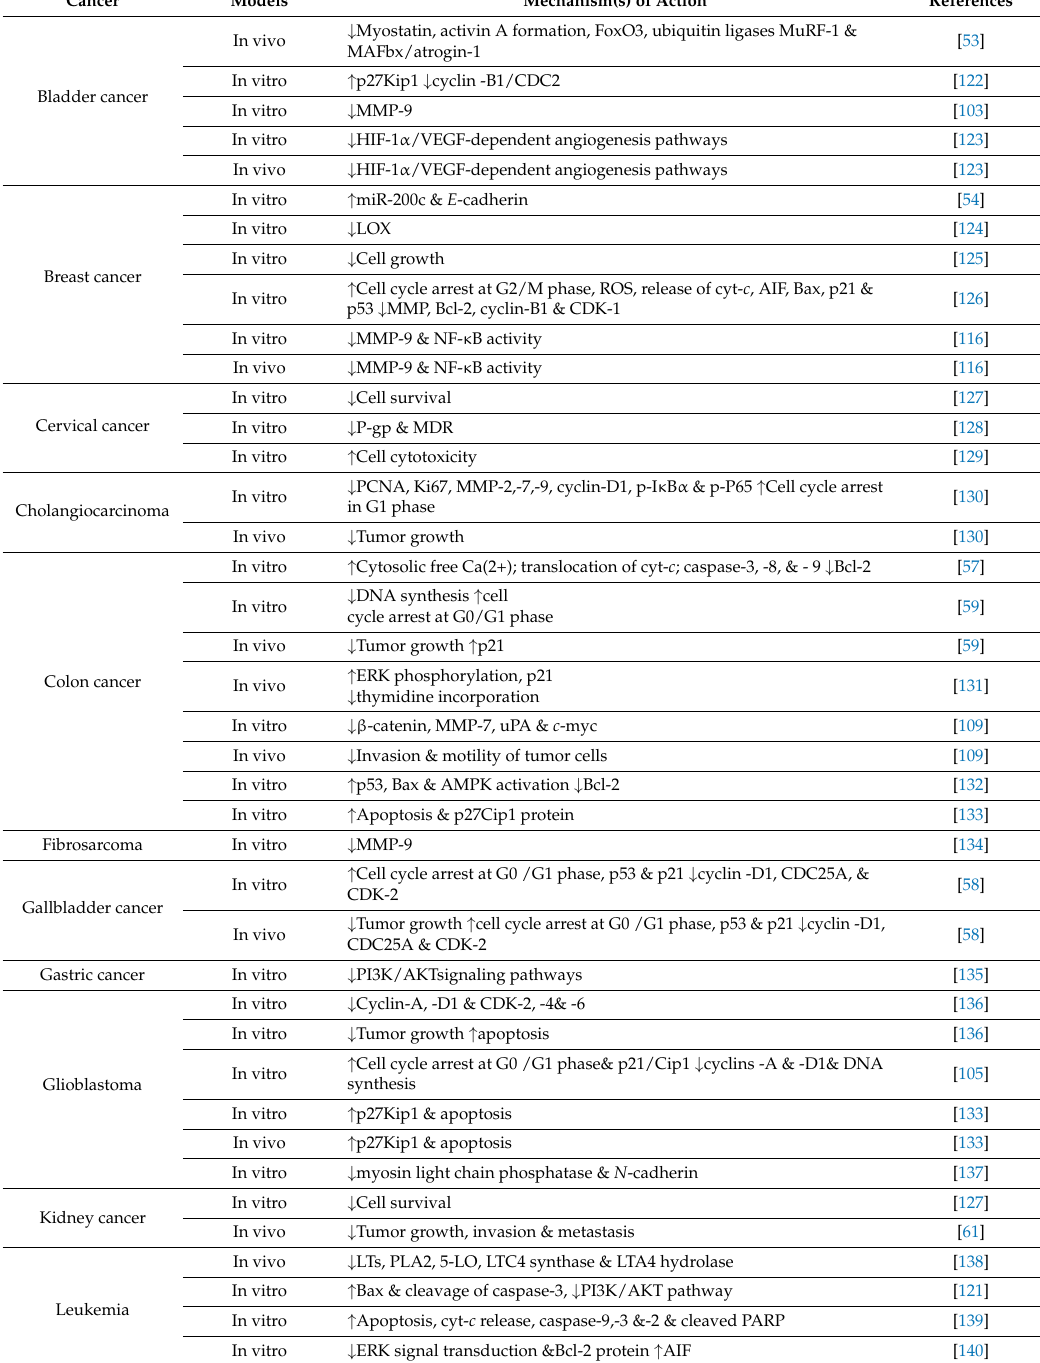
Table 1. Magnolol (MAG) and its mechanism of actions against different